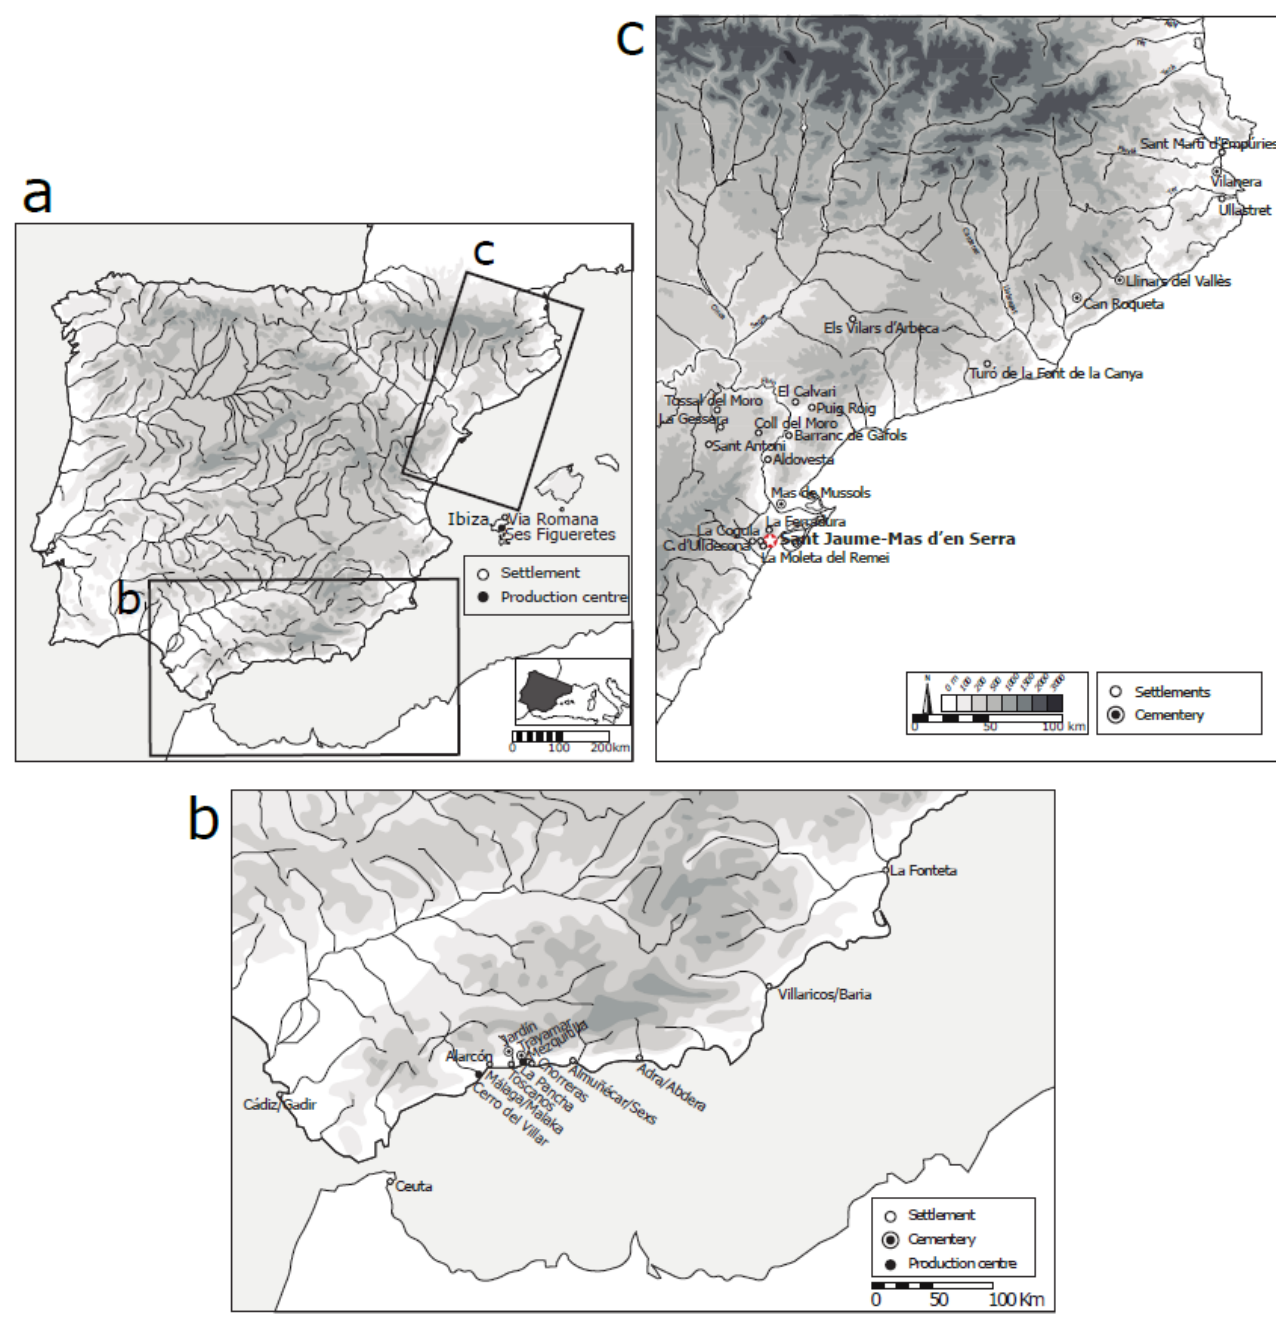
Figure 1. Map of the locations of Phoenician colonies in Ibiza ( a ), on the southeastern coast of the Iberian Peninsula ( b ), and the Early Iron Age reception sites of Phoenician pottery along the northeastern coast ( c ).